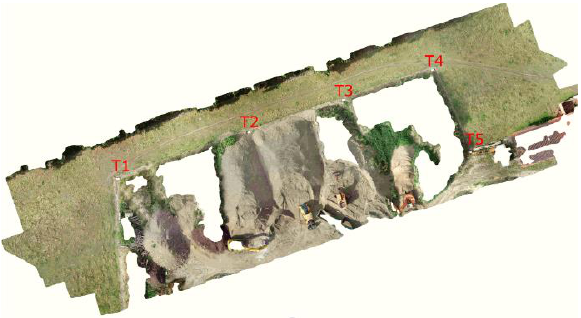
Figure 3 . Location of the targets on the test